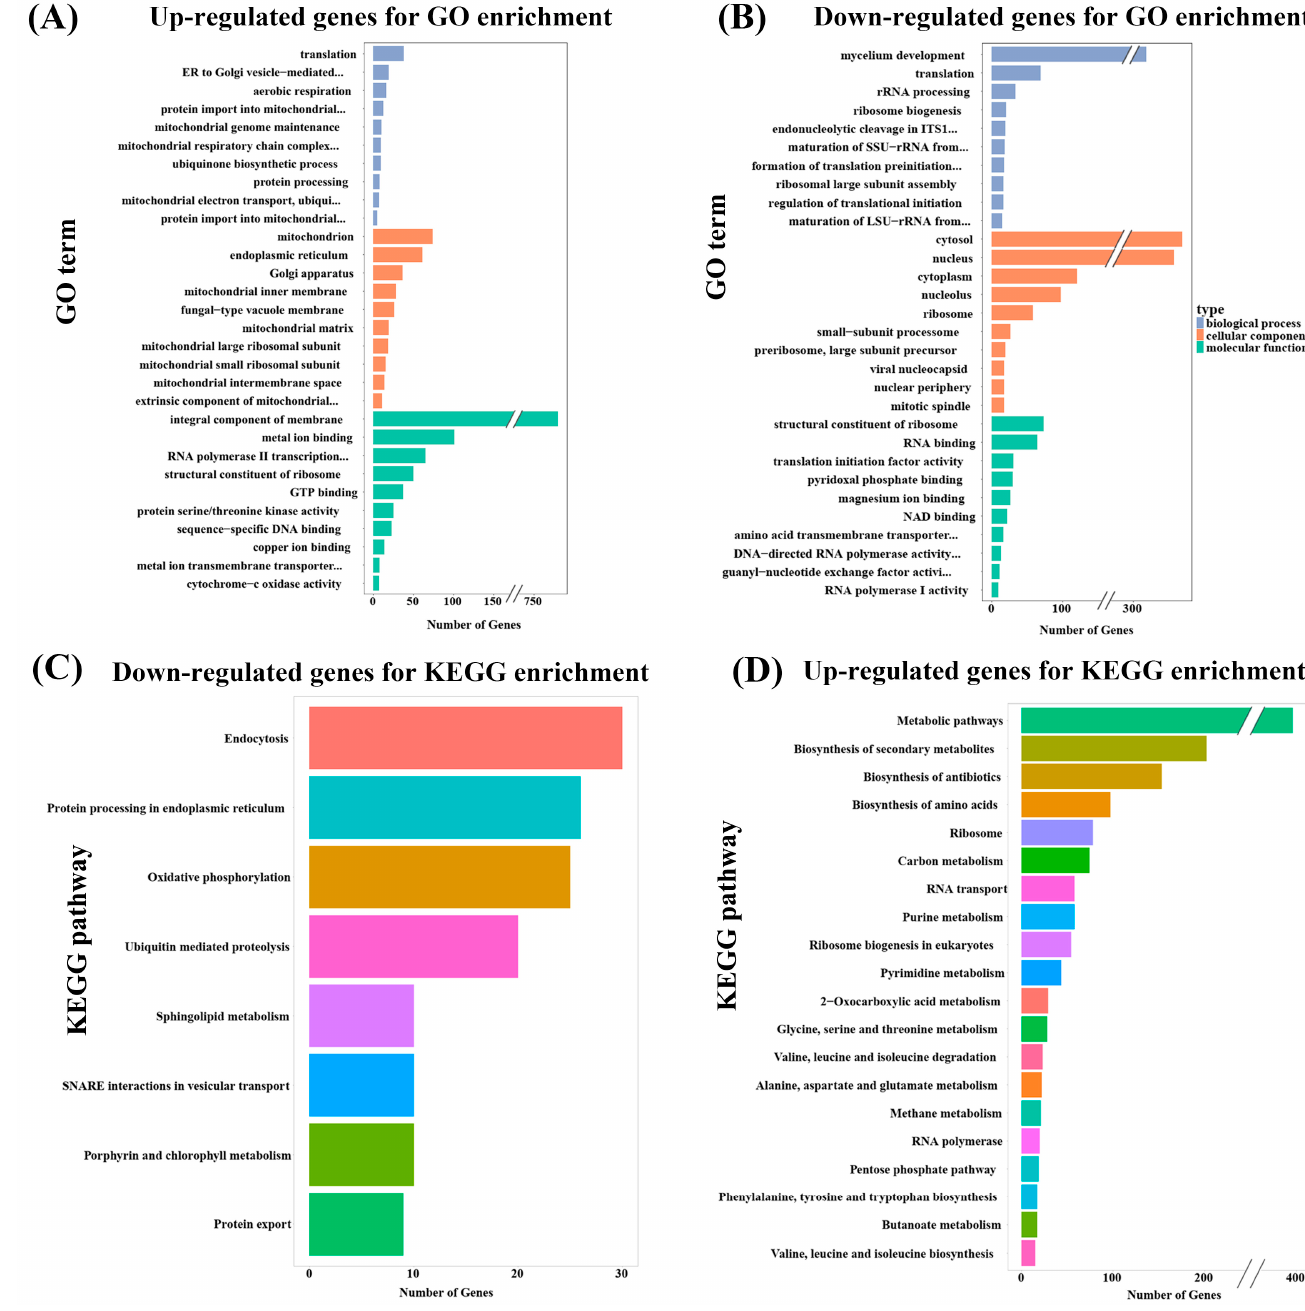
Figure 2. Gene Ontology (GO) and Kyoto Encyclopedia of Genes and Genomes (KEGG) enrichment analyses of differently expressed genes (DEGs) in M. oryzae treated with 9-phenanthrol. The GO enrichment of upregulation ( A ) and downregulation ( B ) of DEGs. The KEGG analysis of upregulation ( C ) and downregulation ( D ) of DEGs.